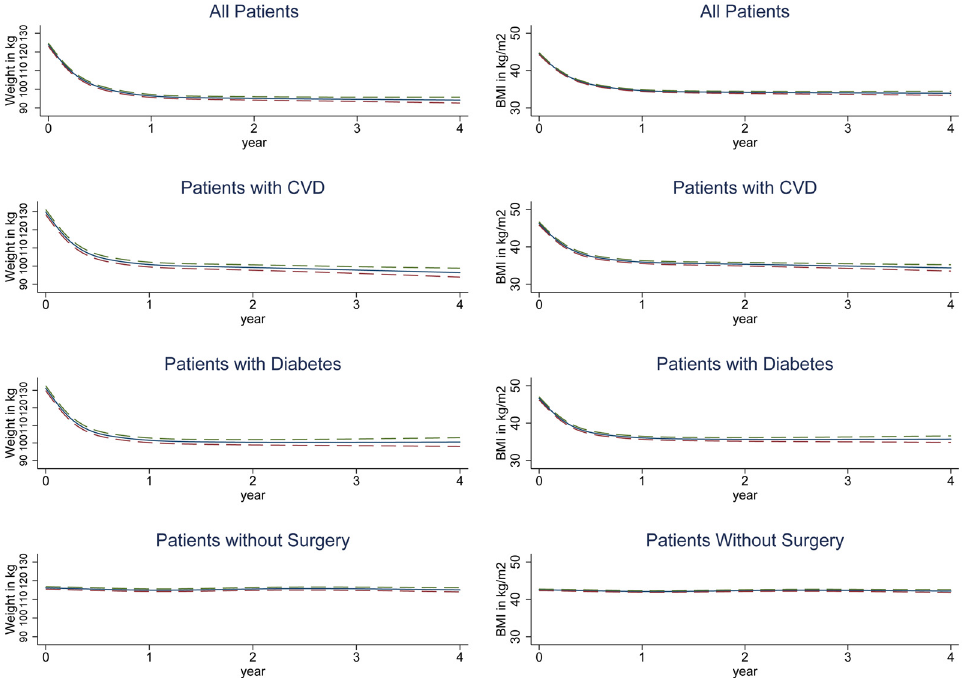
Fig 2. Estimated mean change in weight and BMI over 4 y following bariatric surgery or no surgery. Dashed lines show 95%